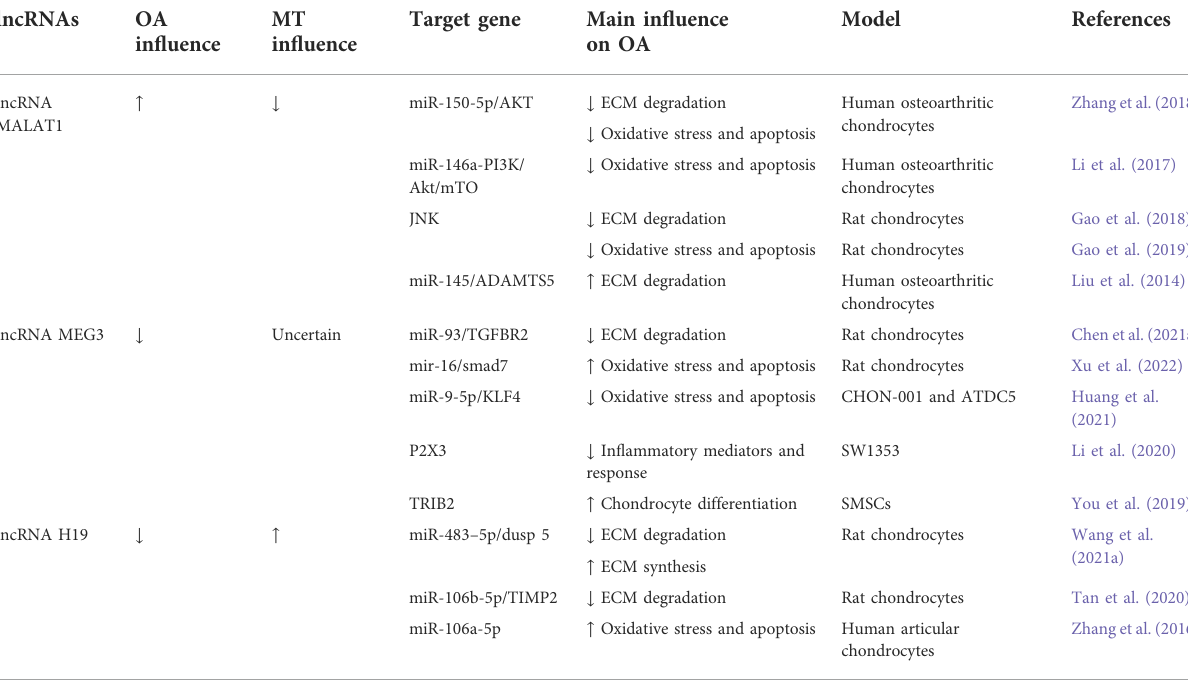
TABLE 2 Summary of differentially expressed lncRNAs concerning the regulatory effect of melatonin on OA discussed in this